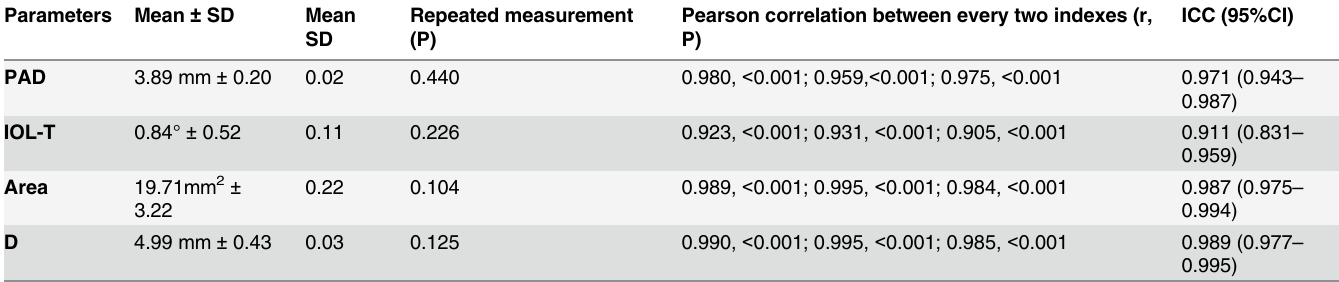
Table 5. The repeatability results of PAD, IOL-T, Area, and D using different statistical analysis